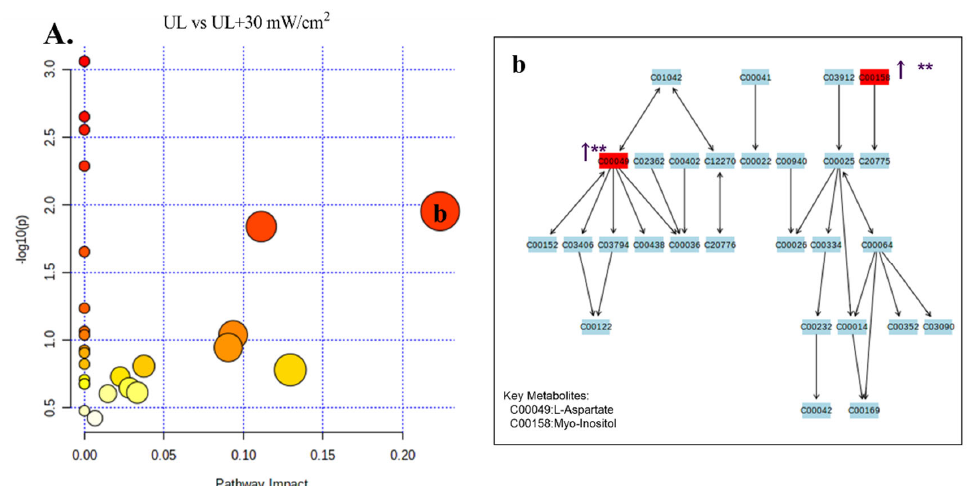
Figure 9. ( A ) Differential metabolic pathway between UL and 30mW/cm 2 LIPUS groups. The color (light to dark) of the point represents the p value (Y ‐ axis), and the size of the point represents the metabolic pathway impact (X ‐ axis). ( A ( b )): alanine, aspartate and glutamate metabolism; ** p < 0.01 vs. UL group.